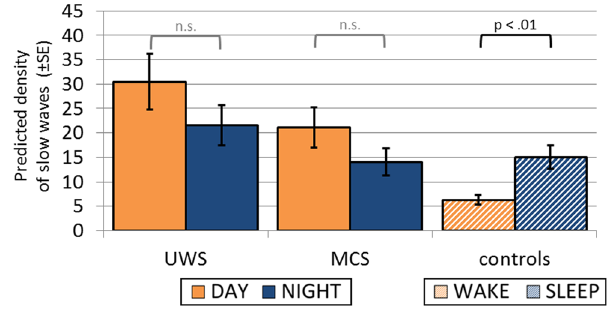
Figure 3. Frequency of occurrence of slow waves across day and night. Note that although liberal detection criteria were applied, the number of detected slow waves was significantly larger during night than day-time in controls only. Abbreviations: UWS = Unresponsive Wakefulness Syndrome; MCS = Minimally Conscious State.